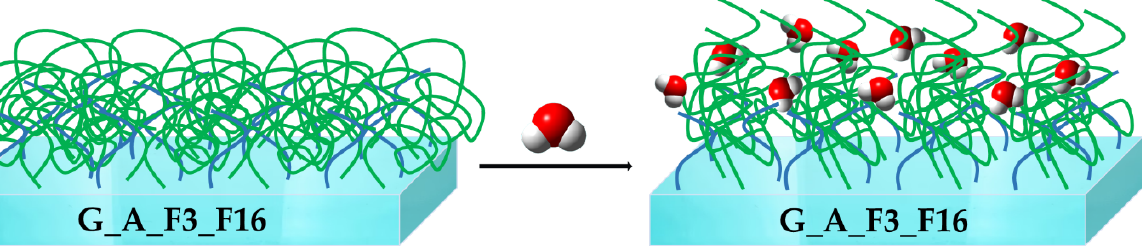
Figure 24. Swelling and elongation phenomena of F16 nonpolar long chain branches taking place at the water/coating interface.